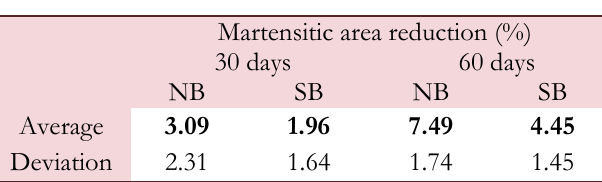
Table 4: Martensitic area reduction